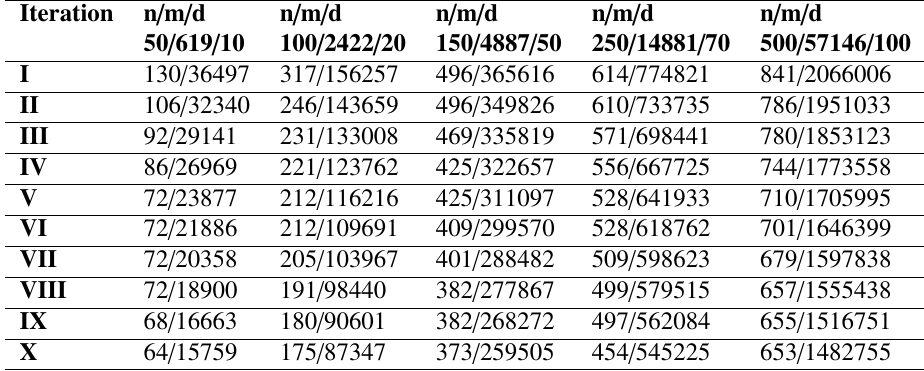
Table 1. The change in the values F ( x ) and F T ( x ) for the AG algorithm